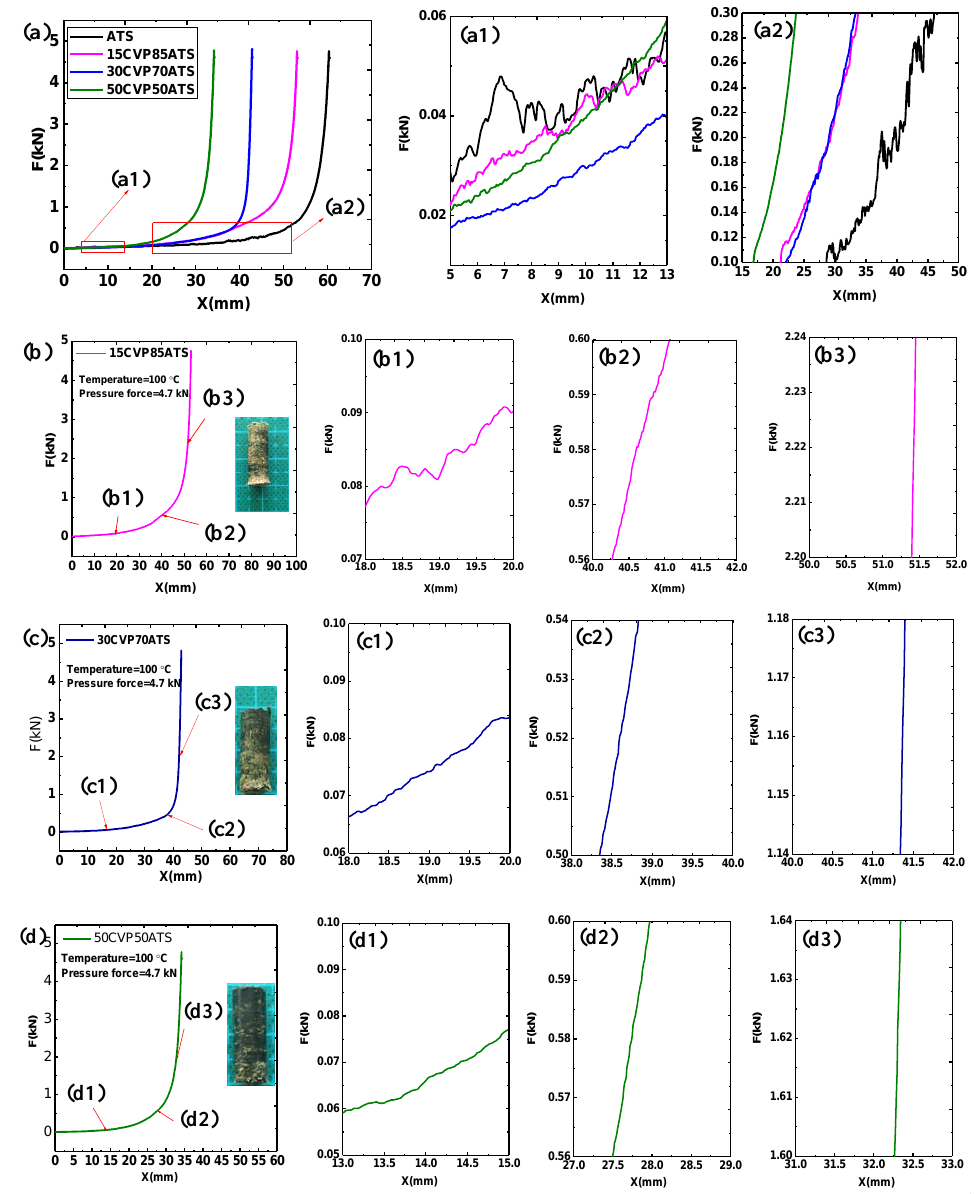
Figure 3. Pelletization process at a force of 120 MPa (4.7 N), temperature of 90 °C, and moisture content of 12% of ( a, a1, a2 ) ATS, ( b, b1, b2, b3 ) 15CVP85ATS, ( c, c1, c2, c3 ) 30CVP70ATS, and ( d, d1, d2, d3 ) 50CVP50ATS.